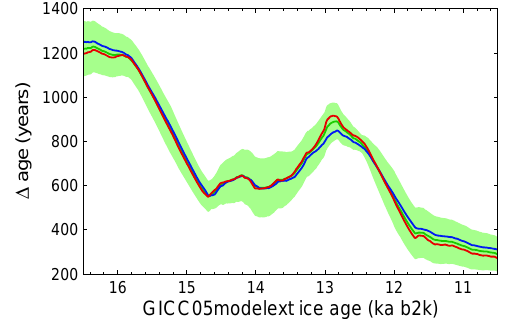
Fig. 9. Accumulation reconstructions from the two firn models (Goujon in blue and dynamical Herron–Langway in orange), from the δ 18 O-based parameterization with 30% reduction in glacial ac- cumulation that is used in the ice flow model (red), and inferred by transferring 20yr mean annual layer thicknesses from NGRIP to NEEM and taking modelled strain into account (green). The black curve and grey envelope show the mean and 2 σ of the four individ- ual reconstructions.